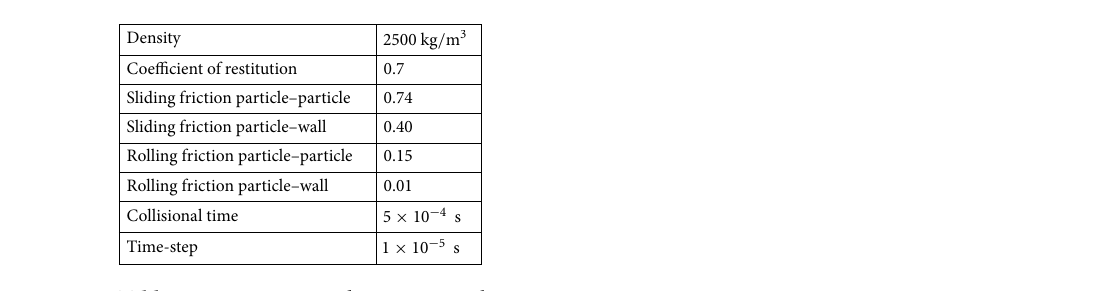
Table 1. Parameters used in DEM